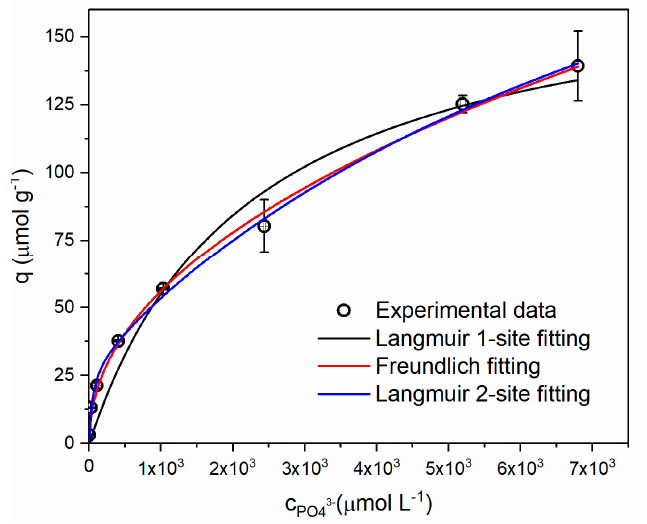
Figure 7. Adsorption isotherms (25.0 ± 0.5 ◦ C) in dispersions of 100 mg of FeOH-Vt in 10 mL phosphate solution fitted to Langmuir (one- and two-site) and Freundlich. Table 2. Adsorption isotherm (25.0 ± 0.5 °C) fitted by NLR analysis.